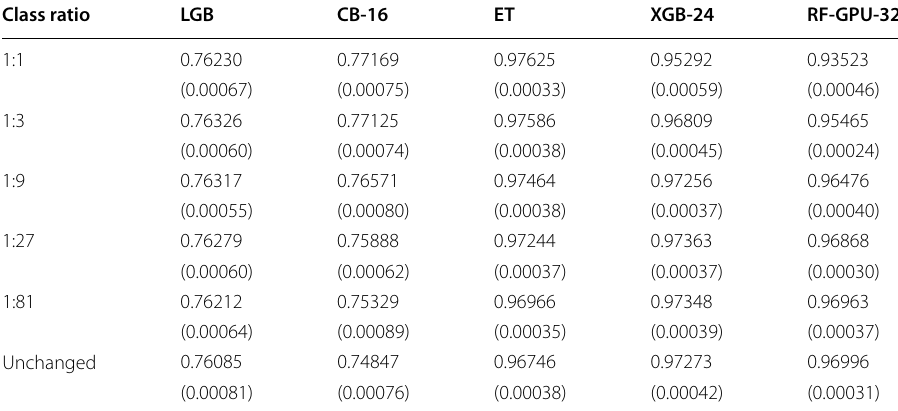
Table 9 Part-D mean and standard deviation of AUC with varying levels of RUS (10 iterations of fivefold